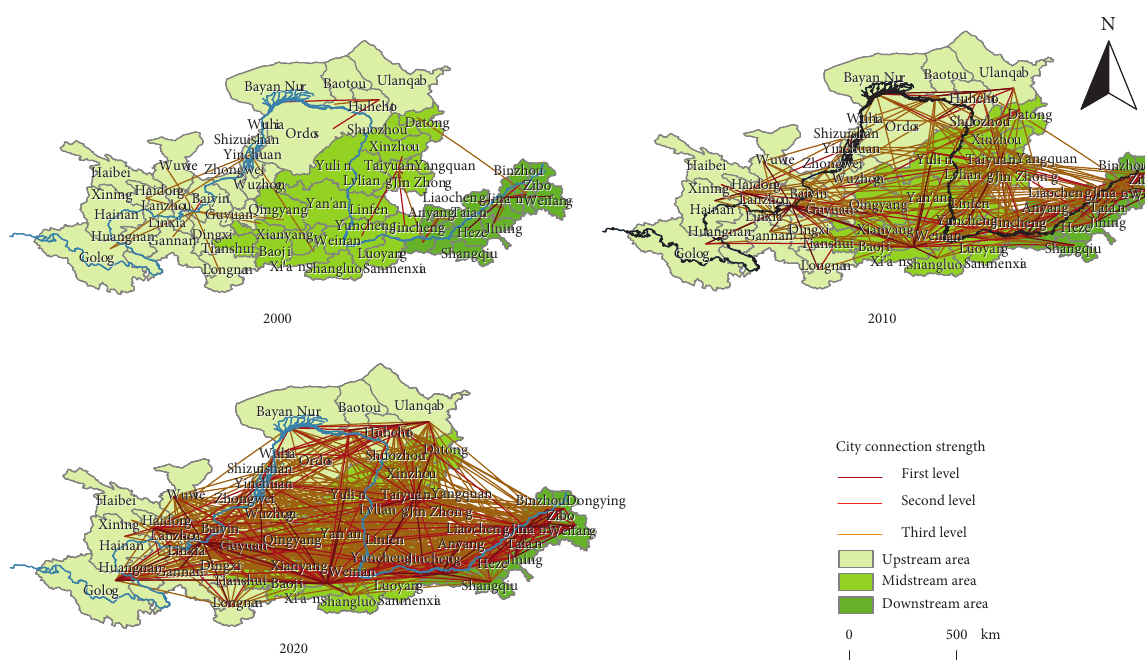
Figure 2: Hierarchical distribution of urban network in river basin.